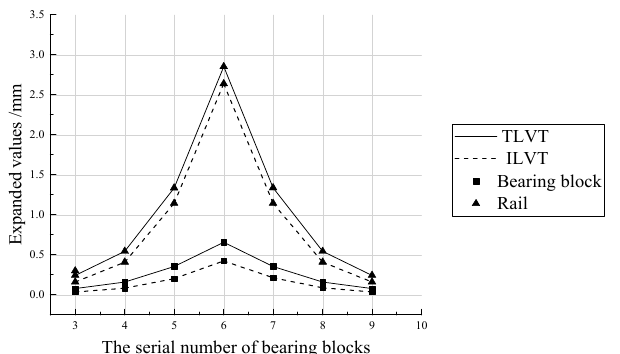
Figure 16. Expansion of lateral spacing of rail and bearing blocks in Working Condition 2.